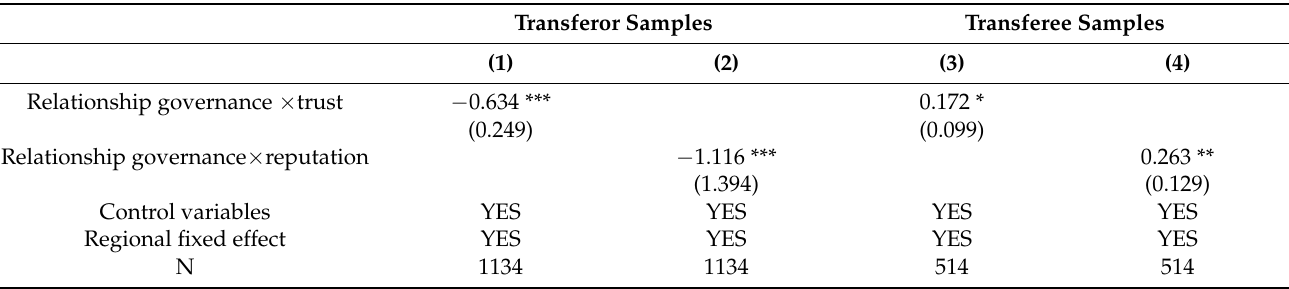
Table 8. Impact of trust and reputation on transfer